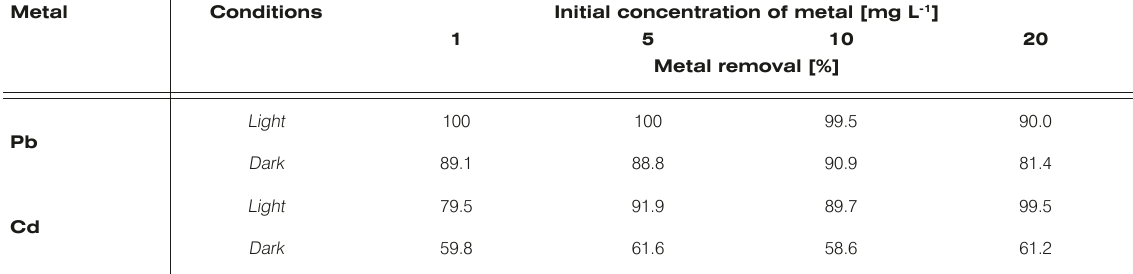
Table 1. The effect of irradiance on biosorption of Pb and Cd by M. aeruginosa after 3 h and 6 h of contact, respectively.